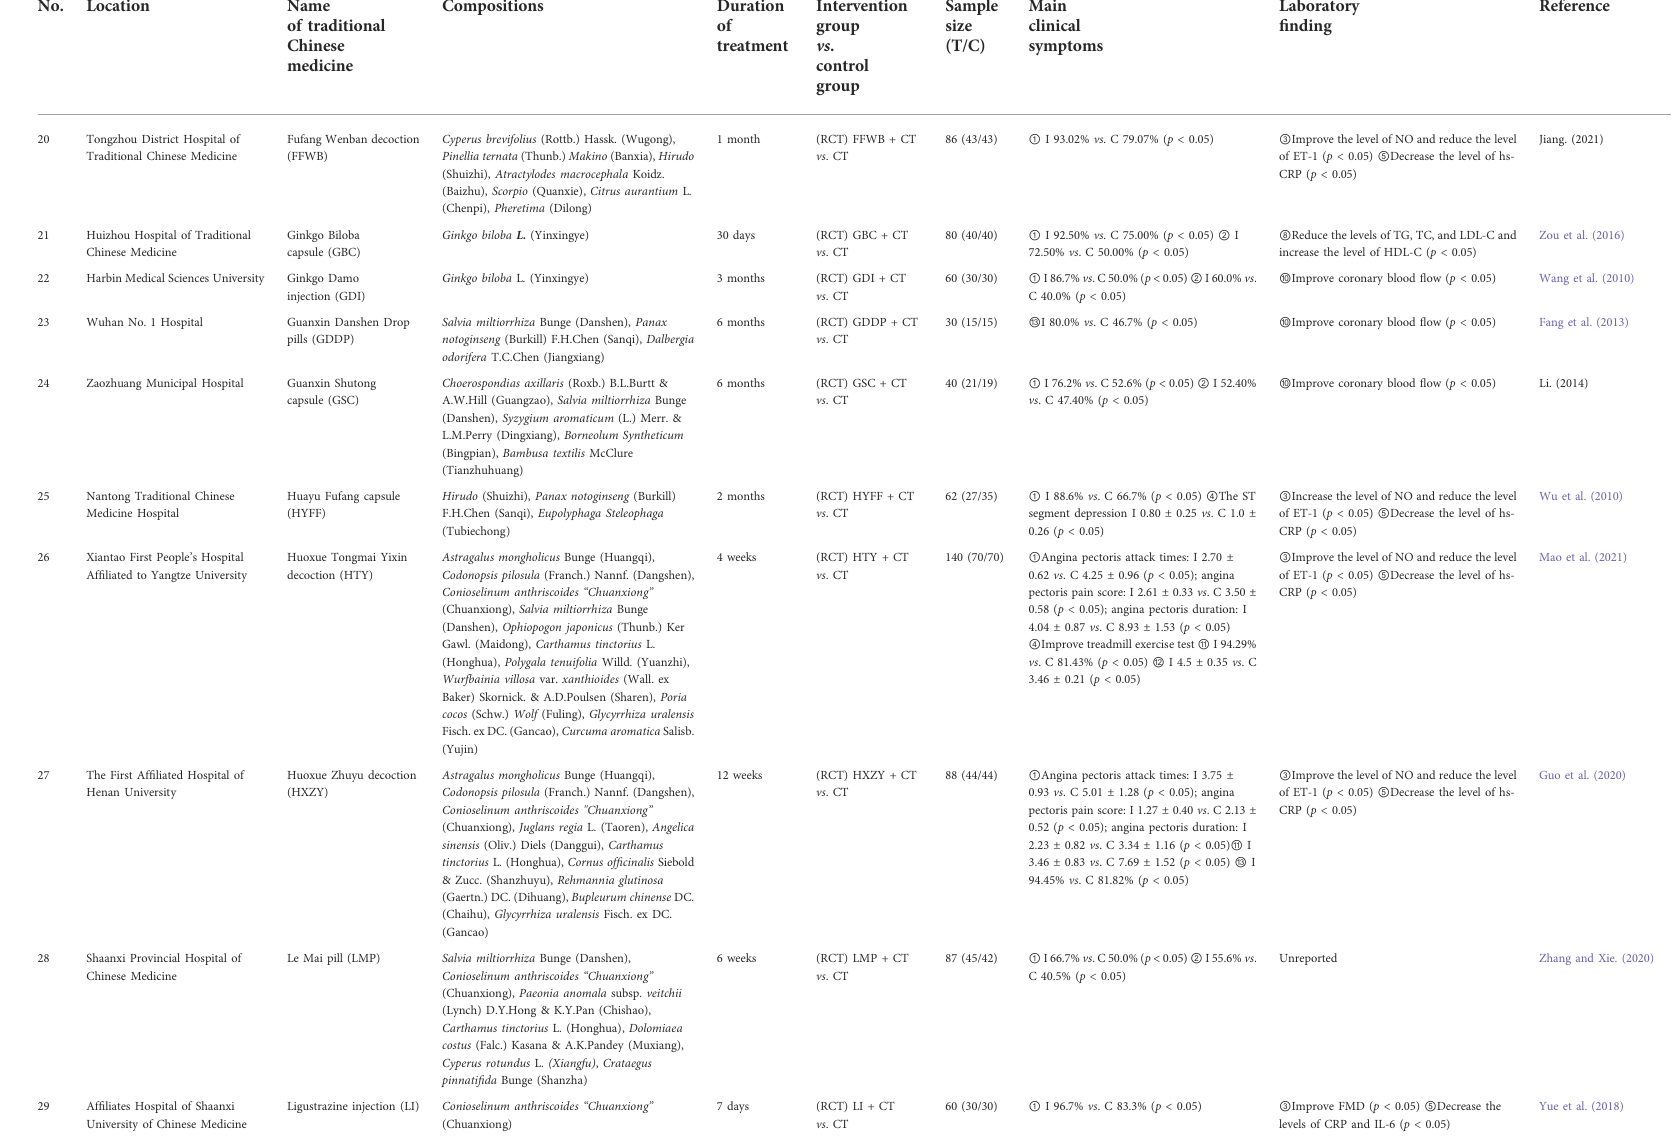
TABLE 1 ( Continued ) Clinical evidence of TCM for